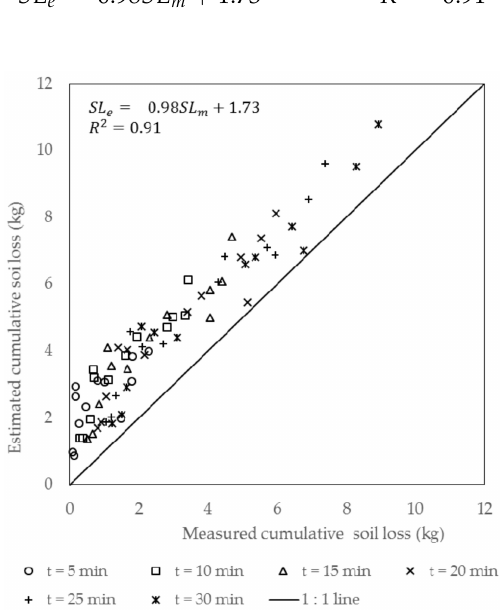
Figure 5. Estimated soil loss versus measured soil